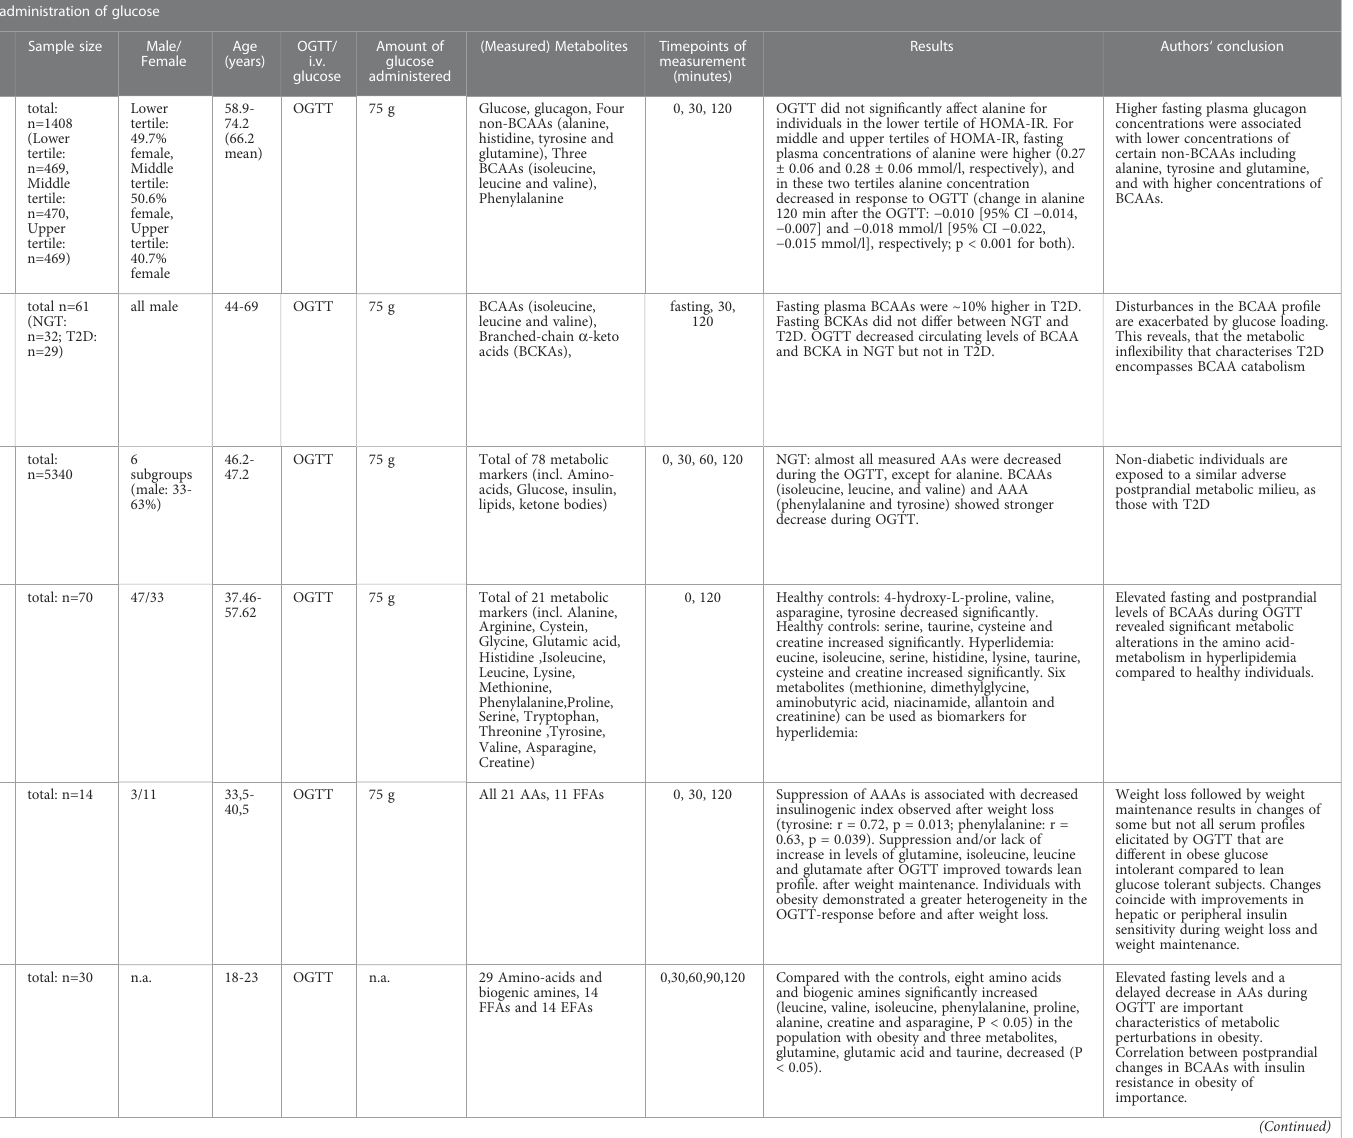
glucose tolerant subjects. Changes coincide with improvements in hepatic or peripheral insulin sensitivity during weight loss and weight